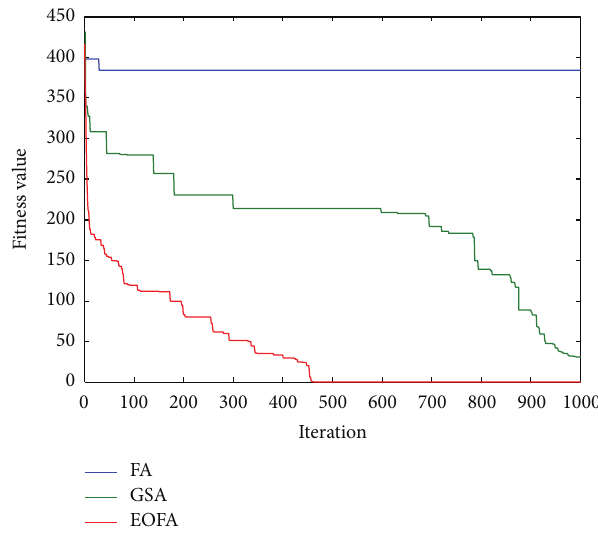
Figure 4: Comparison of performance of FA, GSA, and EOFA for benchmark function F10 with dimension size